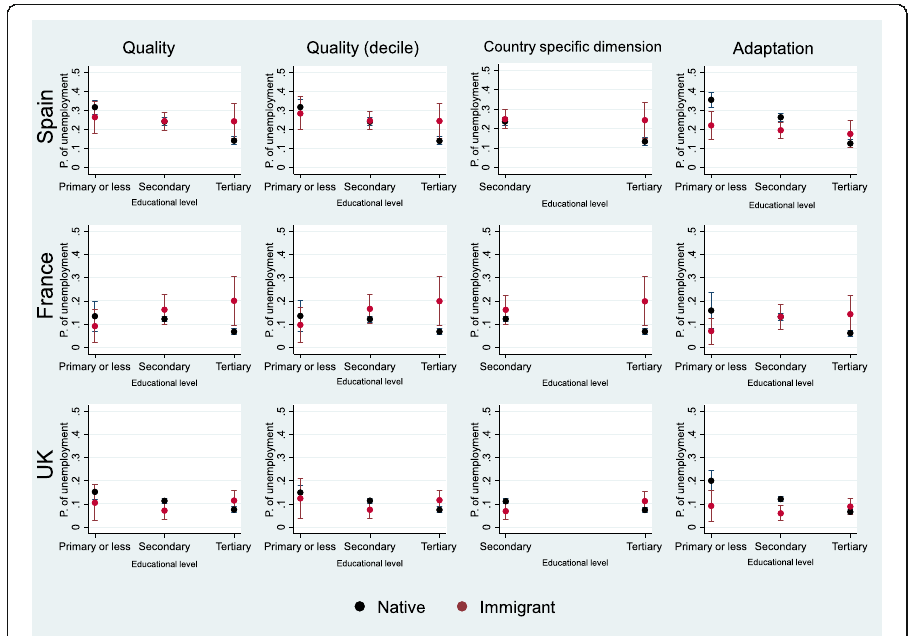
and country of residence. Source : Estimated from models in (Tables 4, 5 and 6 in